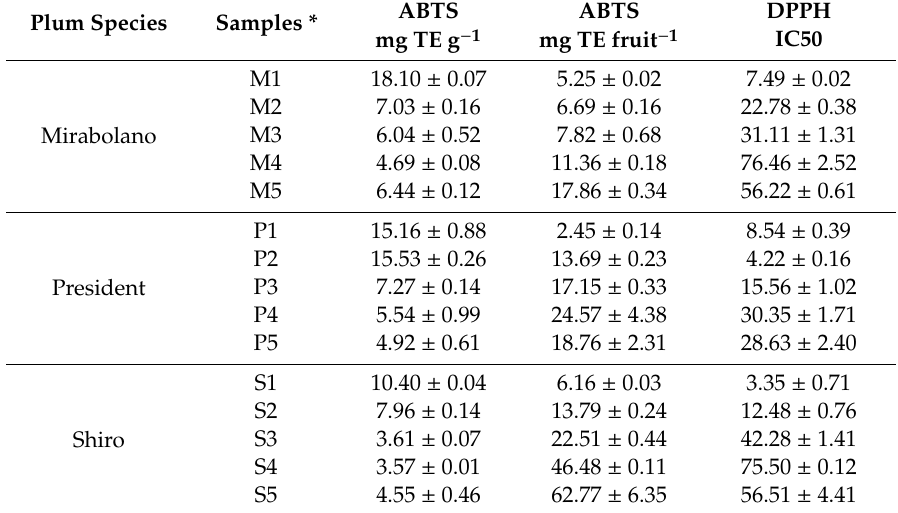
* Plum sample abbreviations are reported in Table 1. ABTS: 2,2 (cid:48) -azino-bis(3-ethylbenzothiazoline-6-sulphonic acid) diammonium salt. DPPH: